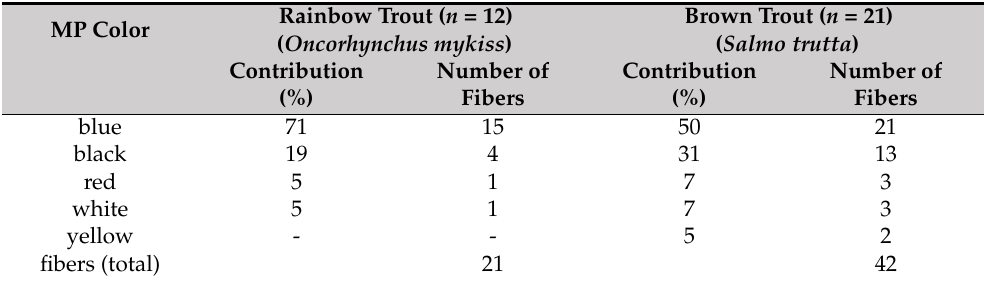
Table 1. Percentage contribution and total number of MP fibers in the GITs of the non-native rainbow trout and brown trout collected from the Mendoza River.